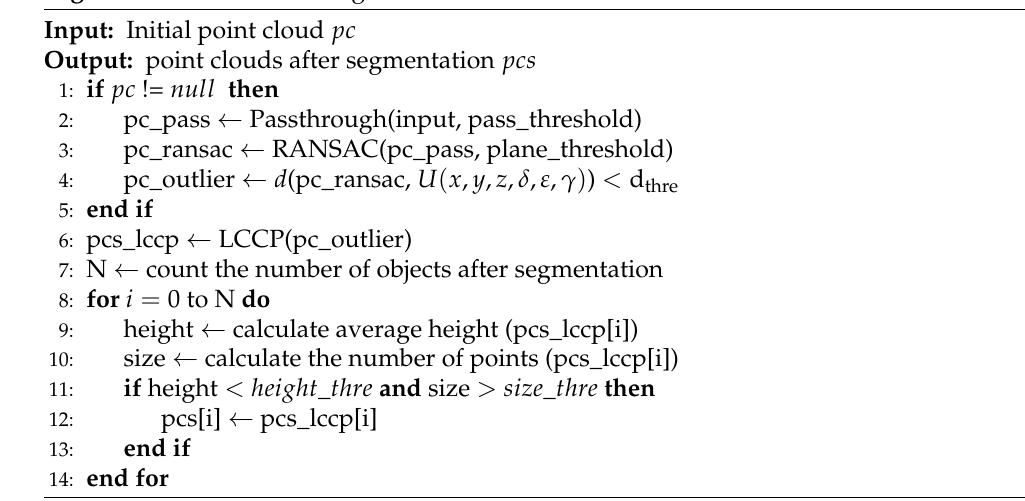
Algorithm 1 Point Cloud